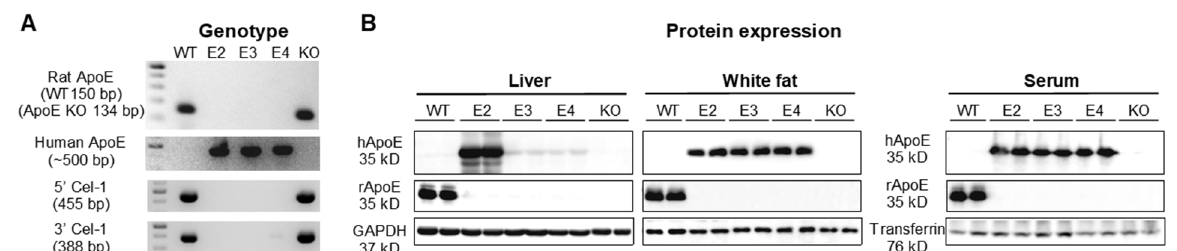
Figure 1. ApoE expressions in transgenic hApoE KI rats. ( A ) Genotyping was performed to detect the genetic constitution of different rats. The ApoE knockout (KO) rat was generated by a 16 bp deletion at 1434–1449 of the ApoE gene. ( B ) Protein expressions of rat or human ApoE in the liver, subcutaneous white fat, and serum were detected by Western blot with specific antibodies. WT, wild type; E2, hApoE2; E3, hApoE3; E4, hApoE4.